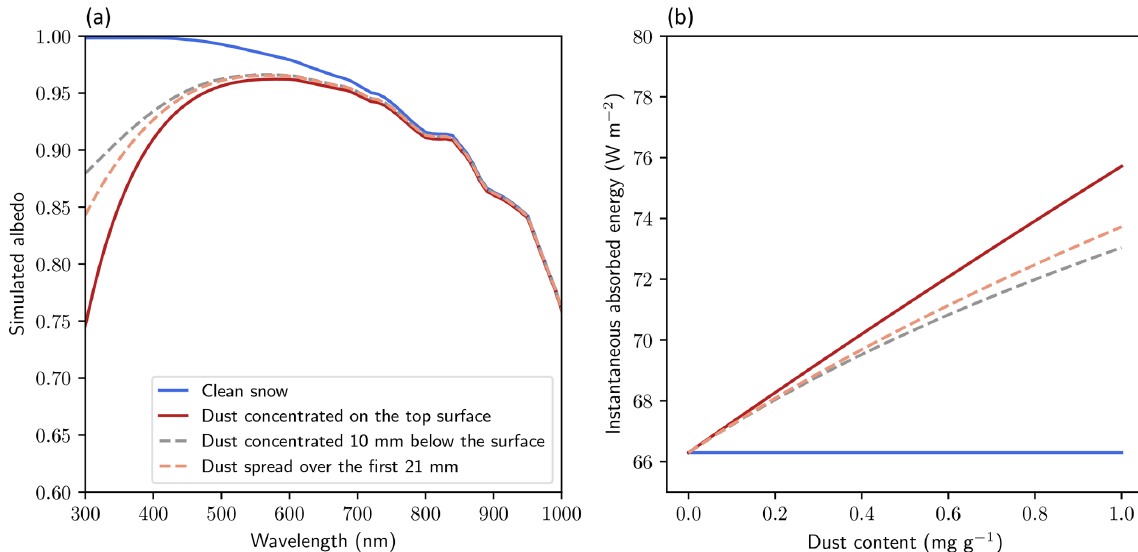
Figure 6. Simulated impact of dust motion on snow radiative properties. (a) Albedo as a function of wavelength for different idealized snowpacks and an initial dust concentration of 1mgg − 1 . (b) Instantaneous absorbed energy at a 70 ◦ solar zenith angle as a function of the initial dust content and for the same idealized